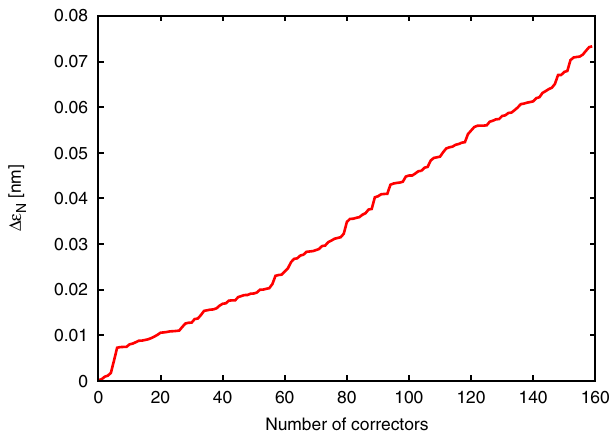
FIG. 20. (Color) Emittance growth caused by a step size error of 10 nm for a varying number of selected quadrupoles (correctors).